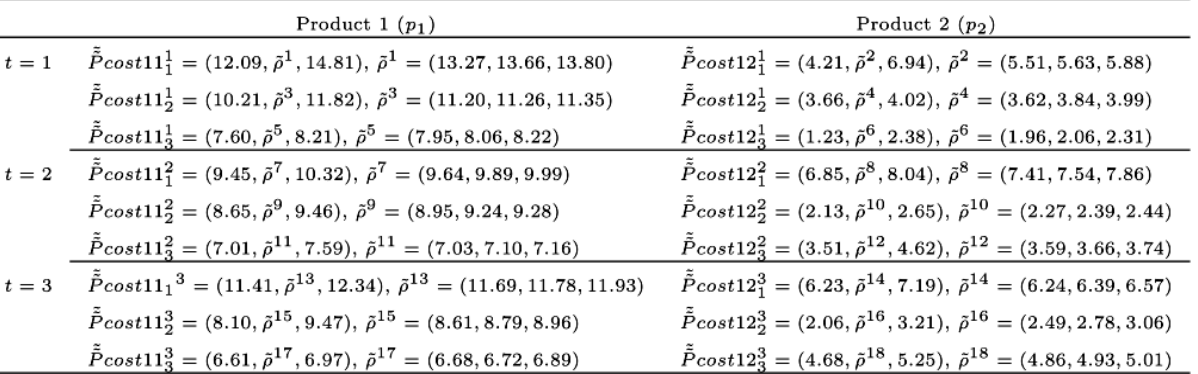
Table 1. Product cost per